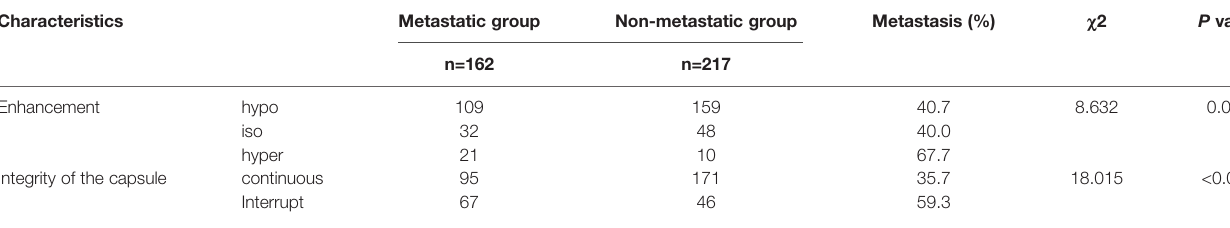
TABLE 3 | CEUS features of PTCs in lymph node metastatic group and non-metastatic group. Characteristics